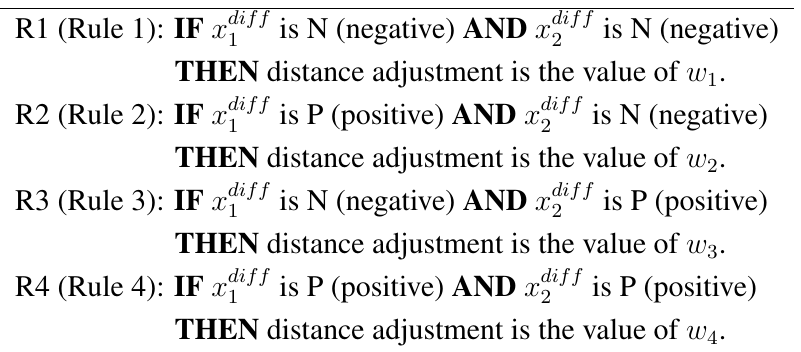
Table 2. Representation of fuzzy